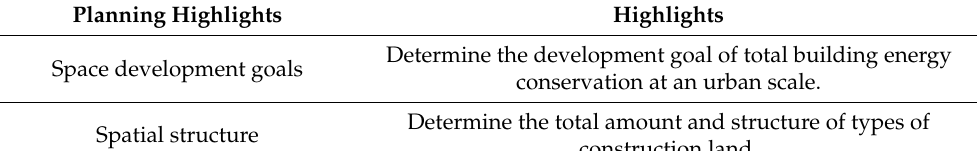
Table 6. Energy conservation planning points in the Harbin Municipal Territorial Spatial Master Plan. Planning